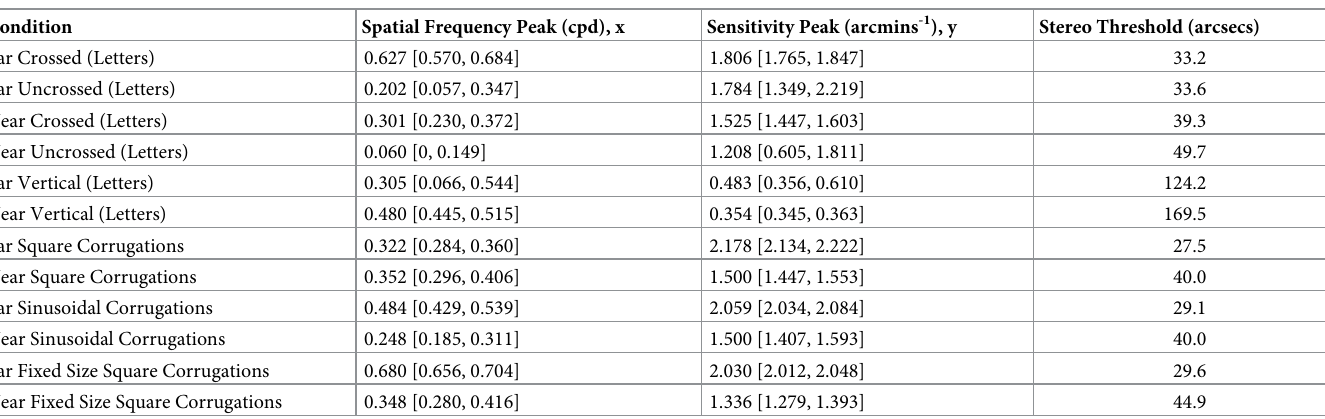
List of the coordinates of the maximal points of the log parabola quadratic fit for each condition and estimated stereo threshold in arcsecs. The x-coordinate for vertex position of the curve is indicated by the spatial frequency peak (cpd) while the y-coordinate corresponds to the sensitivity peak, in arcmins. Larger spatial frequency peak value, x means that the inverted U-shape curve is shifted to the right. Higher sensitivity peak value, y means the curve is shifted upwards with better stereo sensitivity. The 95% confidence intervals are listed in the brackets.